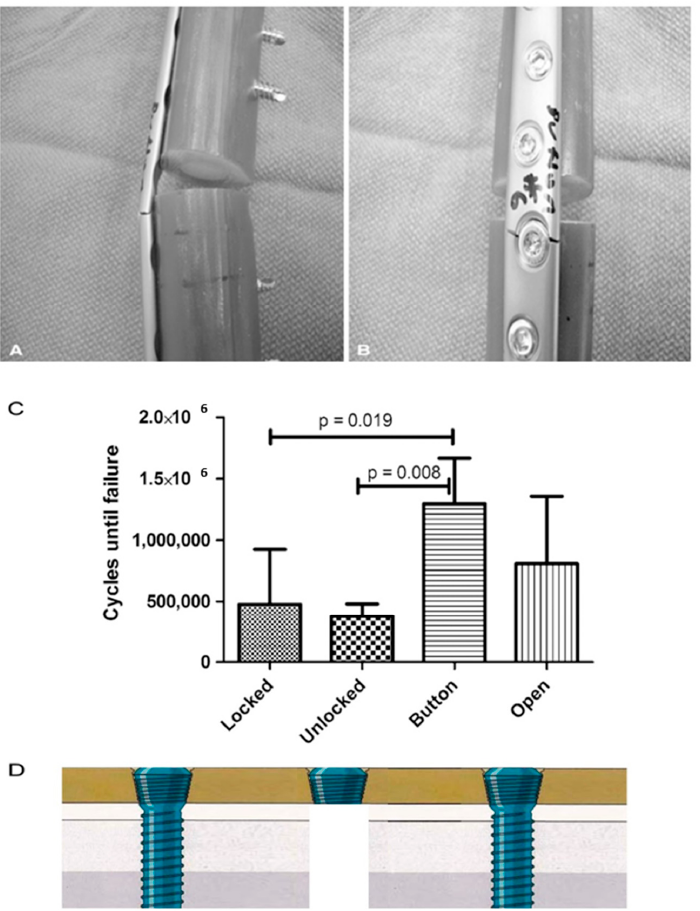
Figure 3. ( A , B ) All plates failed through a screw hole adjacent to the defect as is seen on the ( A ) left and ( B ) right in these representative Button samples. ( C ) The fatigue life in cycles to failure is shown for each plate and screw configuration. (according to [46]). ( D ) The authors did not to date test the strength of the construct near the fracture site for using a single button.